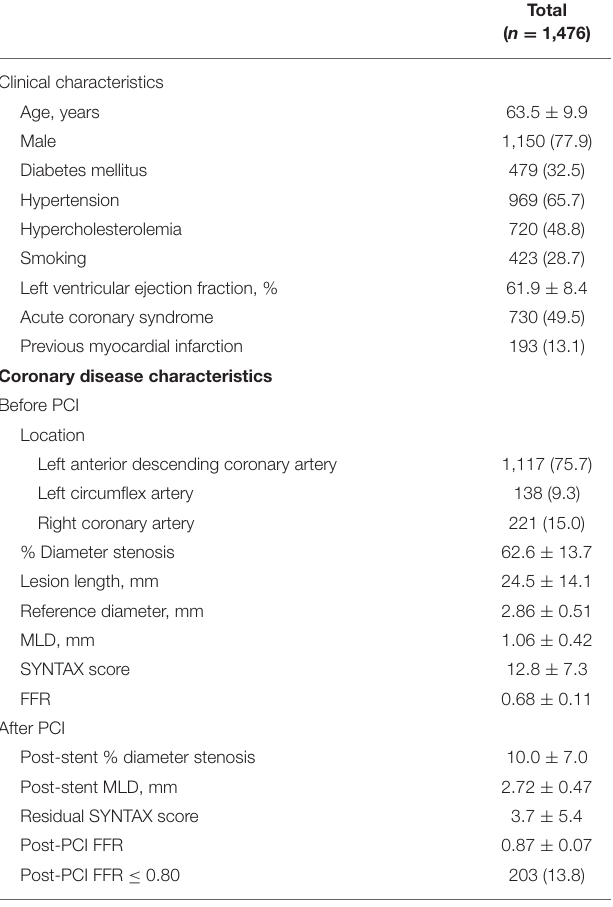
TABLE 1 | Baseline characteristics.